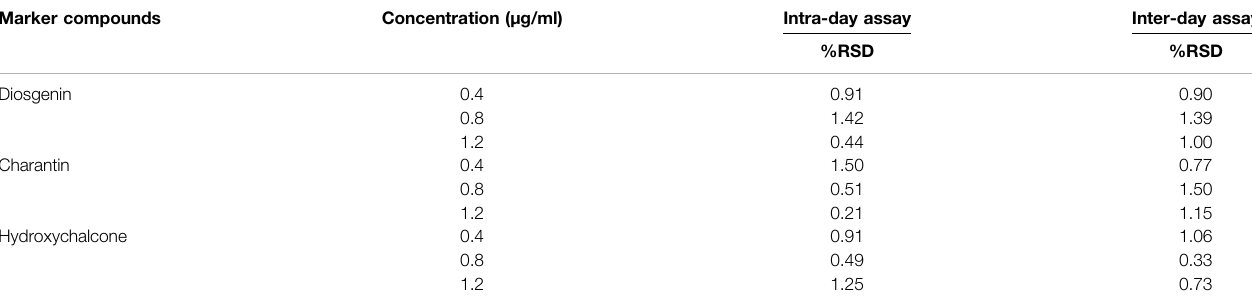
TABLE 6 | Precision of diosgenin, charantin, and hydroxychalcone in rat plasma. Marker compounds